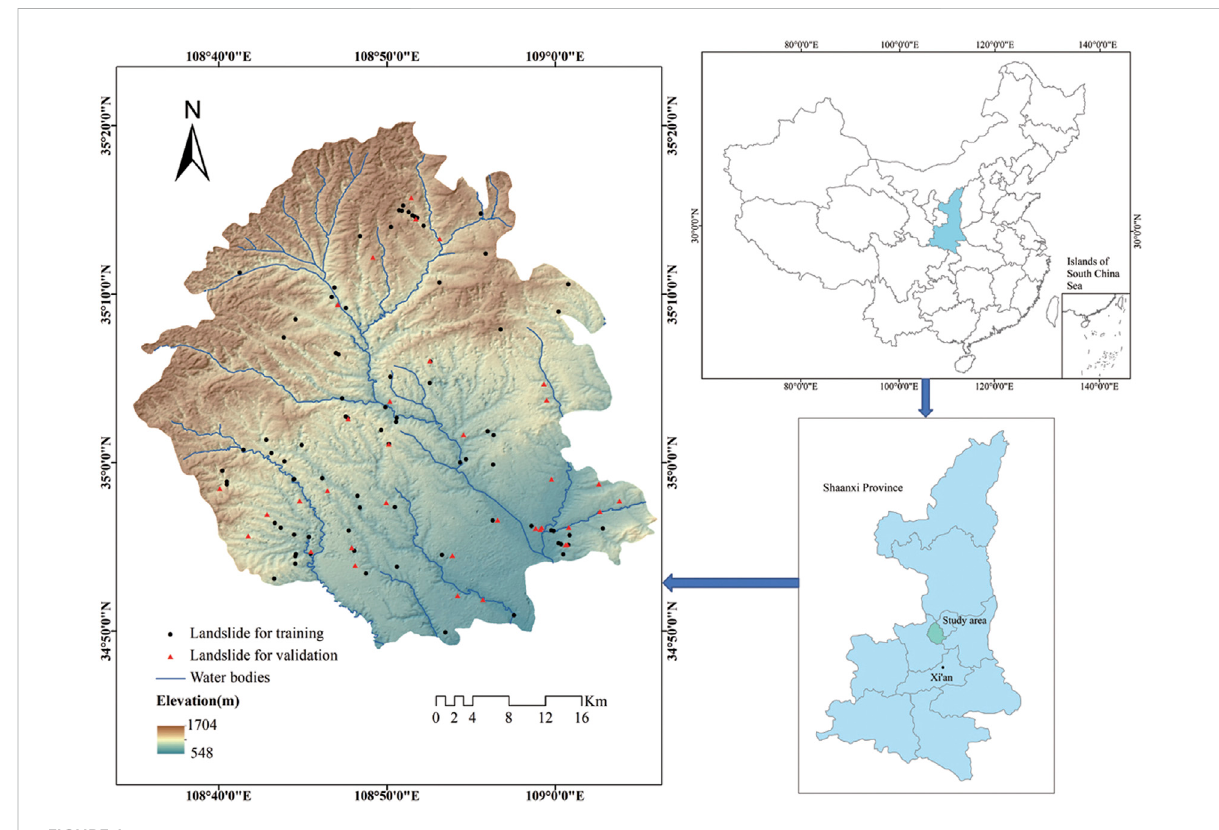
FIGURE 1 Location of the study area and landslide inventory